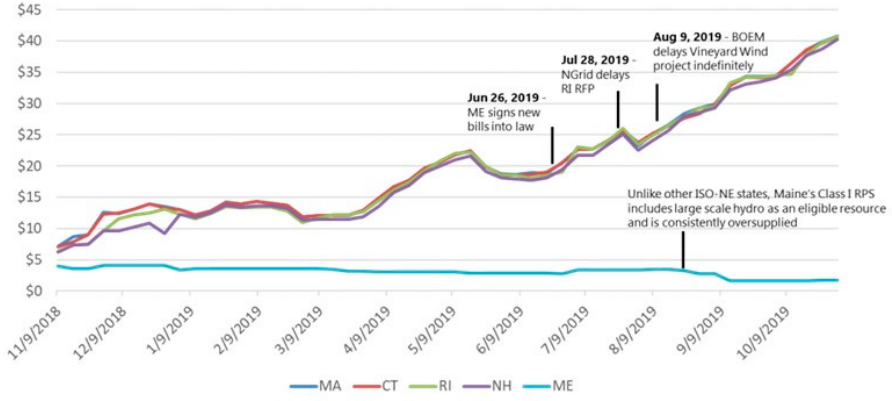
Figure 11. ISO-NE class 1 REC prices ($/REC).